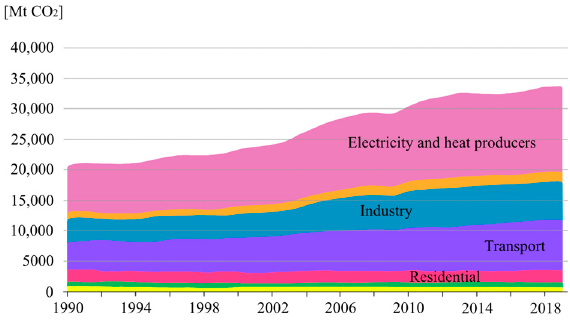
Figure 2. CO 2 emissions by sector, world [1].